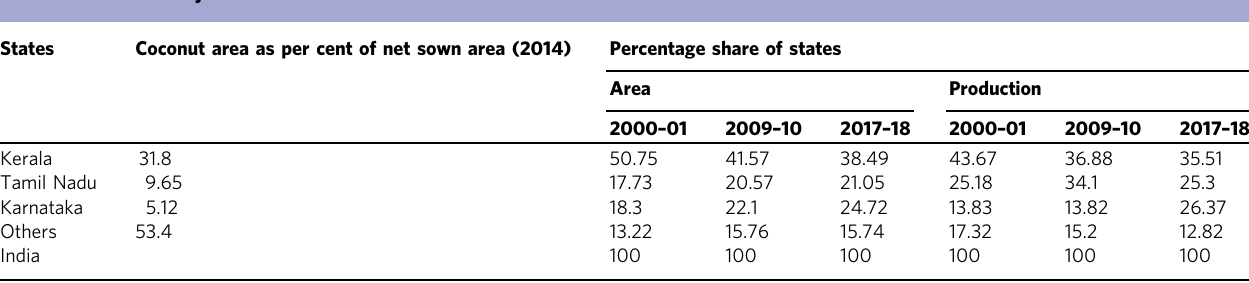
Source: Computed based on Coconut Development Board statistics. (Values are in